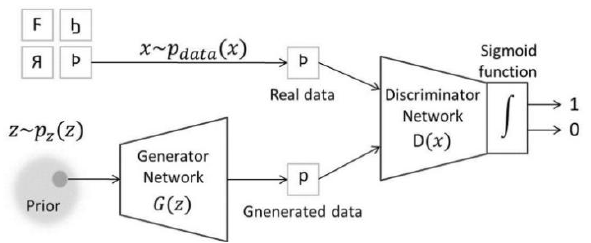
Figure 1. The schematic diagram of the generative adversarial network (GAN).